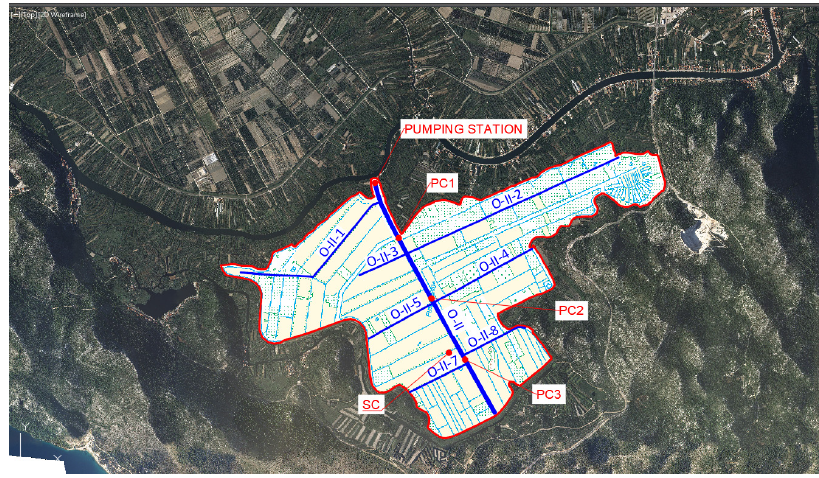
Figure 2. Layout of the drainage canal network in the Vidrice polder with names of individual canals.